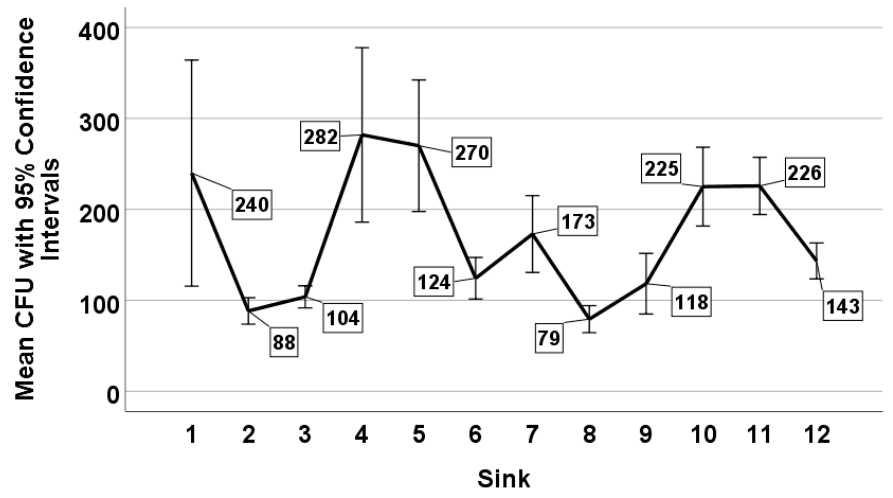
Figure 4. Mean Legionella counts (CFU / mL) as a function of sampling location.